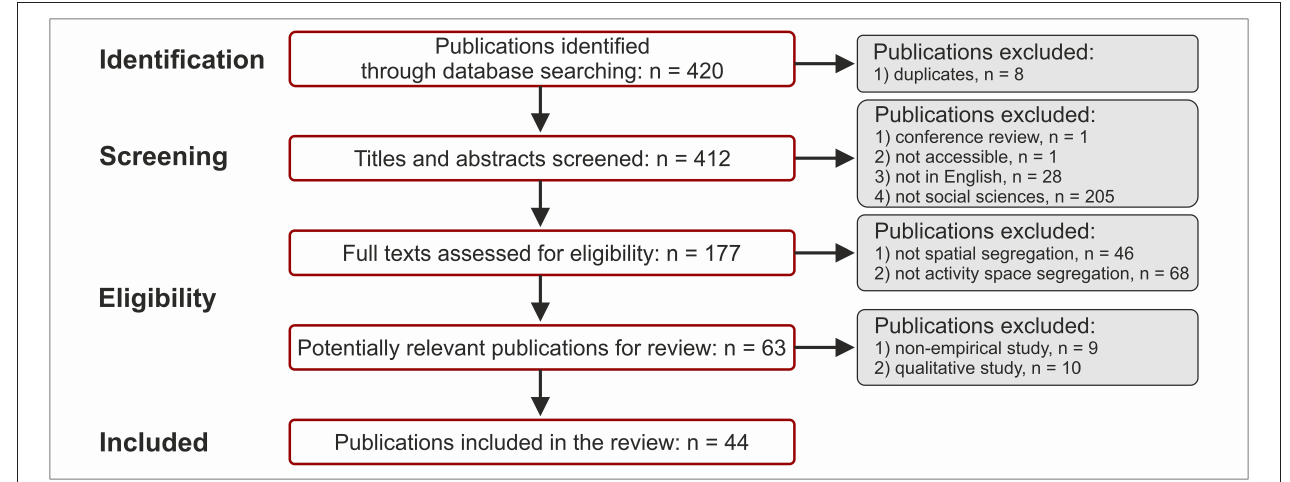
FIGURE 1 | Article selection process.